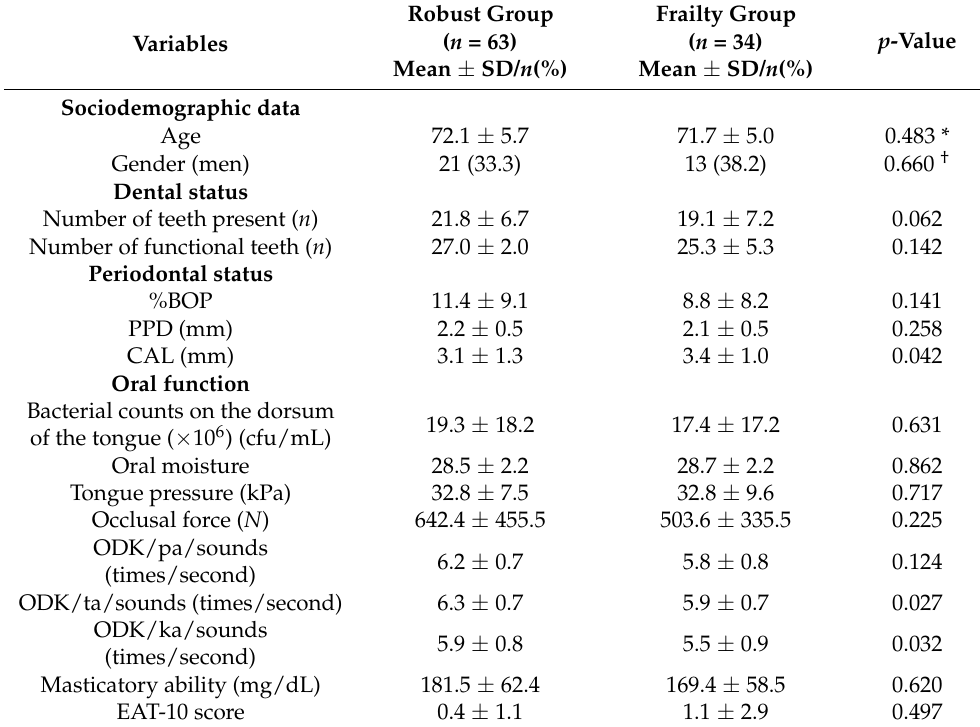
Table 2. Baseline characteristics of the study population according to the presence of frailty at